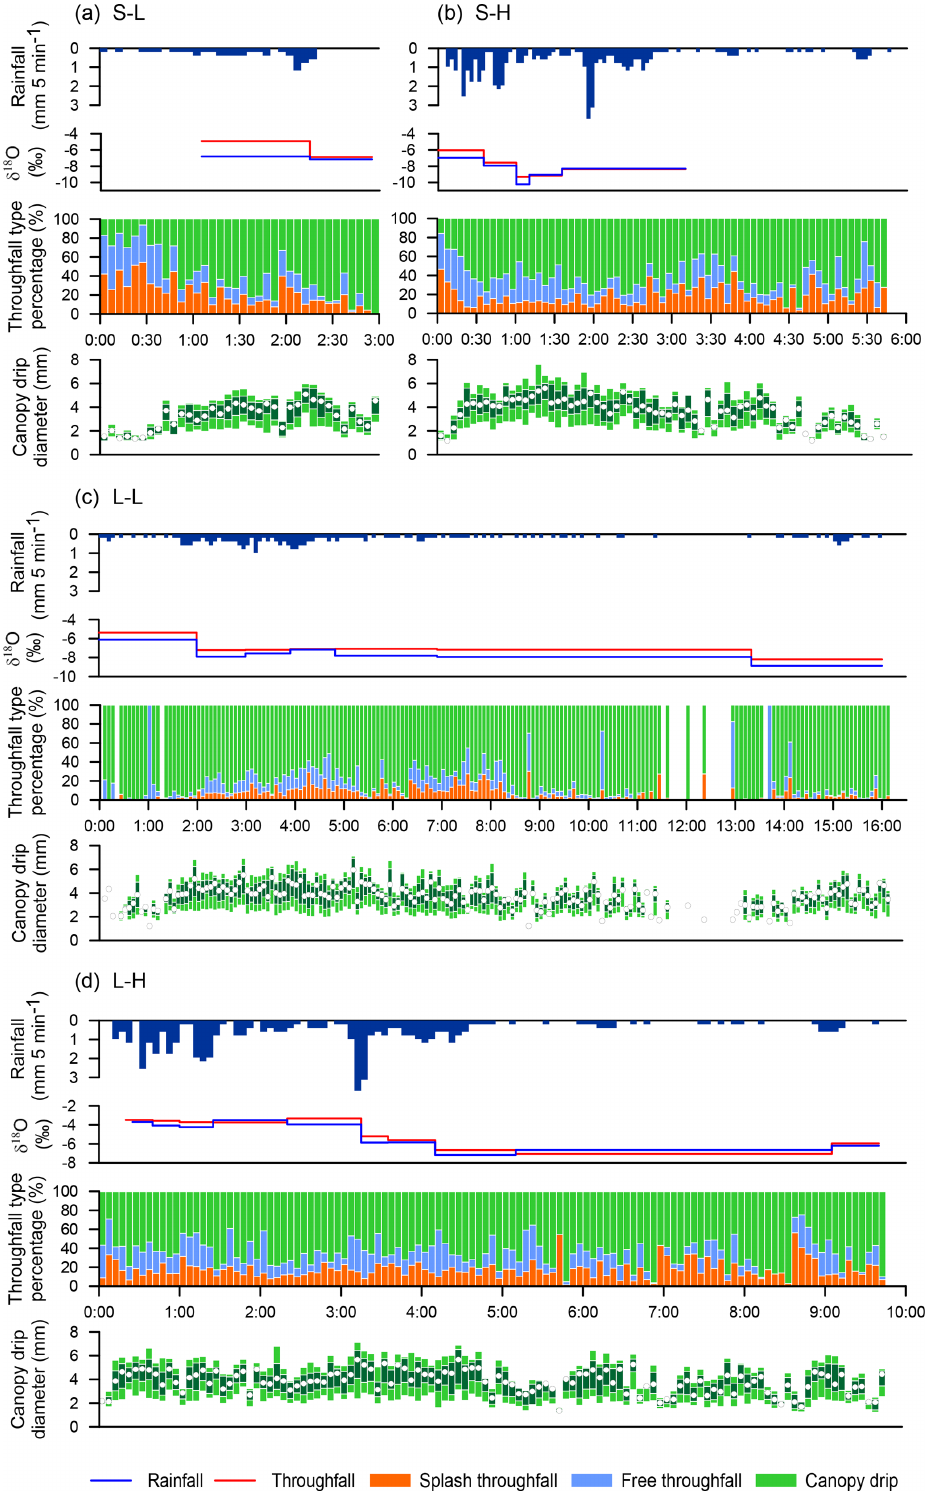
Figure 5. Temporal evolution (time since the start of the event) of rainfall dynamics (5min time step), δ 18 O in rainfall and in throughfall (collected by the sequential samplers every 5mm of rainfall), the throughfall type percentages based on volume, and the drop diameter of canopy drip (5min time step). (a) Short-duration–low-intensity event (S–L), (b) short-duration–high-intensity event (S–H), (c) long- duration–low-intensity event (L–L) and (d) long-duration–high-intensity event (L–H). The drop diameter is shown in the boxplots with the respective cumulative drop volume percentiles (light green denotes 10% and 90%, dark green denotes 25% and 75%, and the white dot denotes